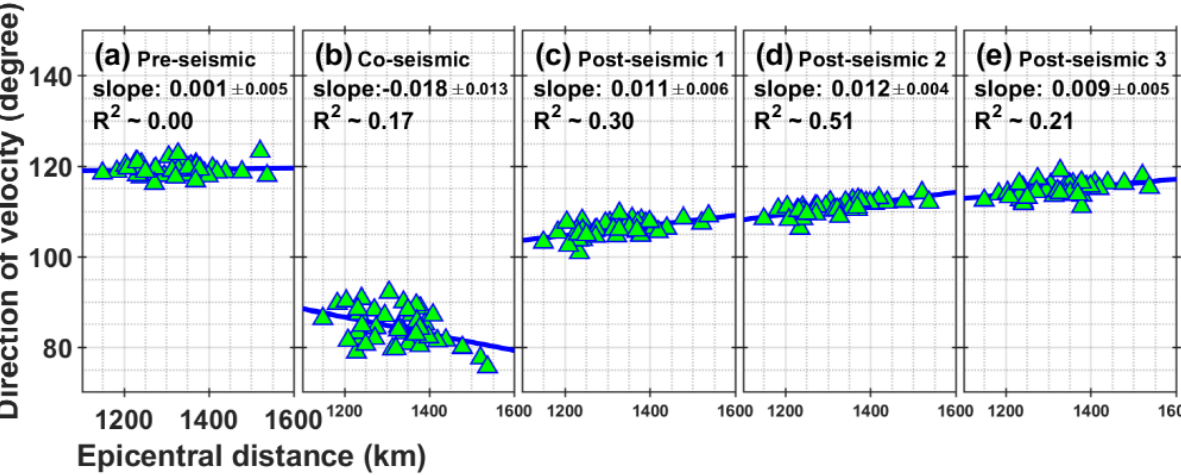
Figure 3. Direction of the GNSS velocity vectors with epicentral distance for each station in the five periods (i.e., ( a ) Pre-seismic, ( b ) Co-seismic, ( c ) Post-seismic 1, ( d ) Post-seismic 2, ( e ) Post-seismic 3). The direction of the velocity vector represents the angle in degrees clockwise from north (that is, north = 0 degrees and south = 180 degrees). The green triangles represent the directions of the crustal velocity vectors for the GNSS stations in degrees. The solid blue lines indicate the linear fit with the data. The coefficients and 95% confidence intervals for ‘slope’ are calculated as the linear relationship between two variables. R 2 is the coefficient of determination for a best-fit line.